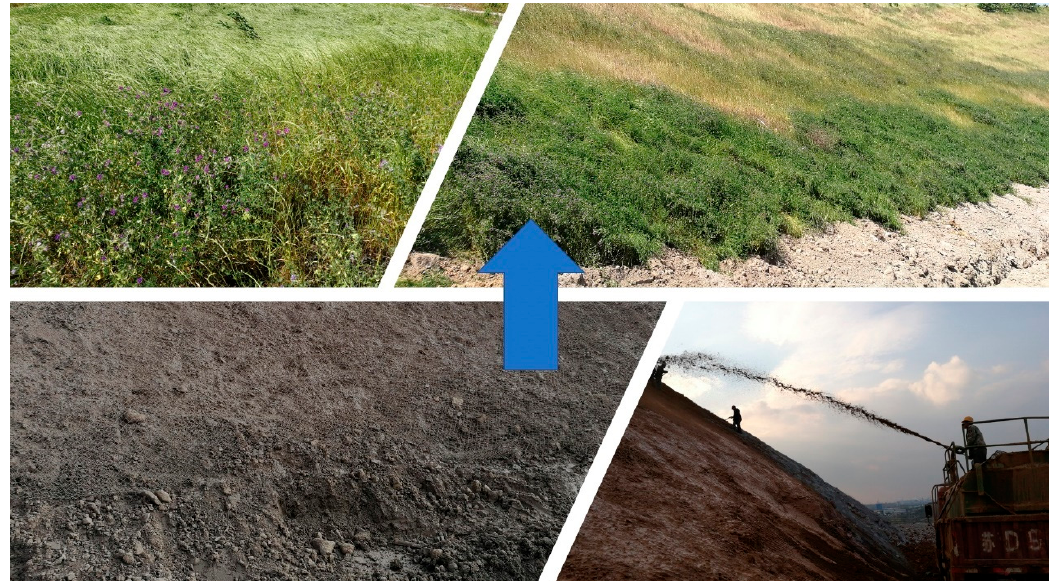
Figure 1. External-soil spray seeding (ESSS) technique.